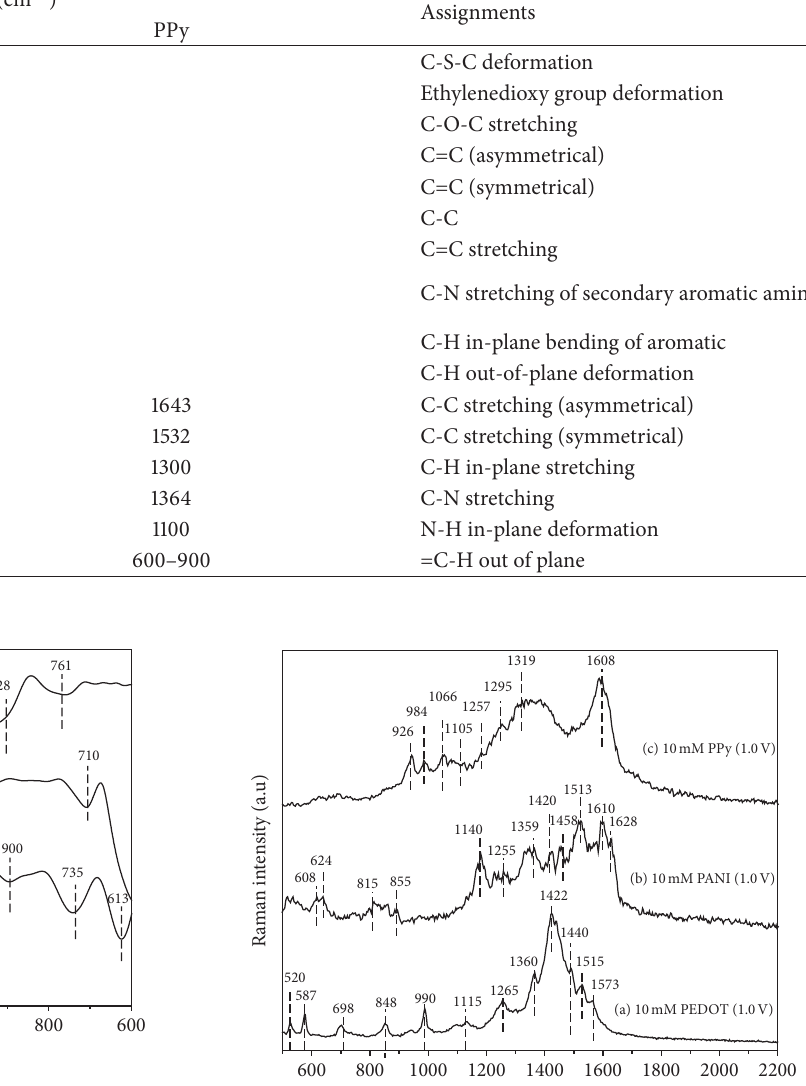
Figure 3: The FTIR-ATR spectra of (a) PEDOT, (b) PANI, and (c) PPy obtained from solution containing 10mM monomer and 0.1M LiClO 4 . Figure4:Ramanspectrafor(a)PEDOT,(b)PANI,and(c)PPyfilms